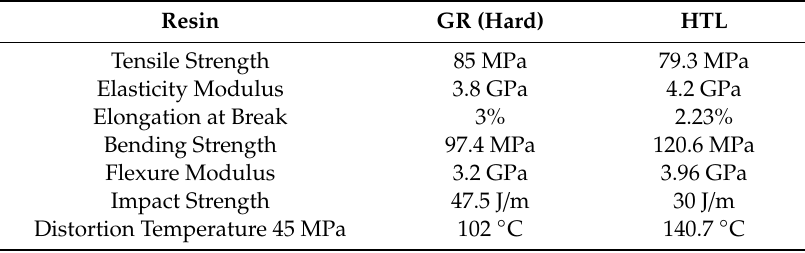
Table 3. Material properties of GR and